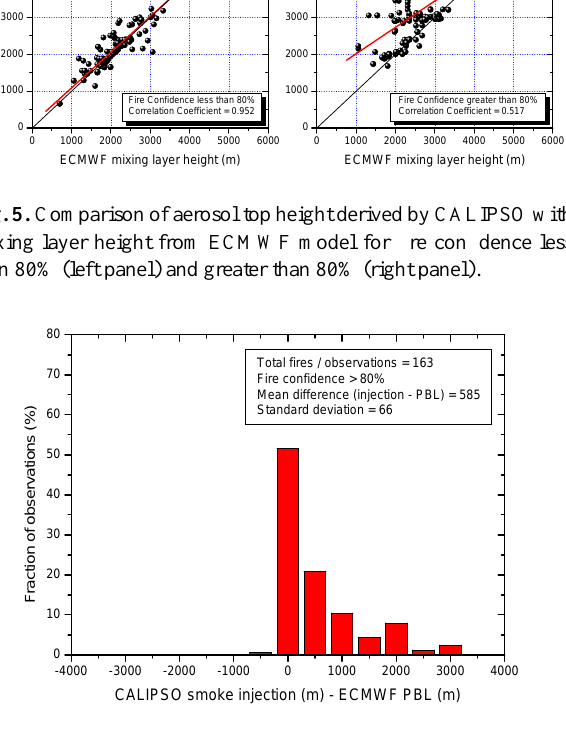
Fig. 6. Frequency distribution of the differences between CALIPSO derived smoke injection height and ECMWF’s mixing layer height for the cases with fire confidence greater than